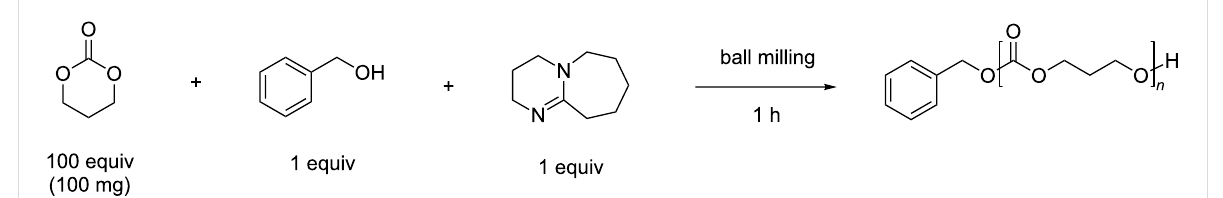
Table 2: Vibration frequency and ball size and number effects. a,b .